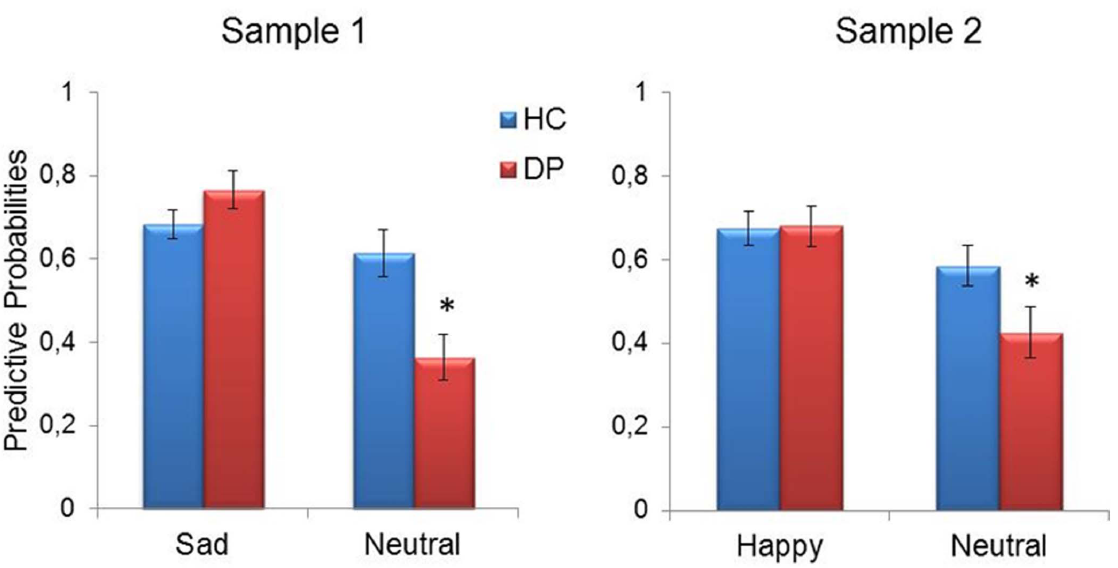
Figure 2. Results from Gaussian Process Classifier (GPC). Comparison of the predictive probabilities to patterns of brain activation to emotional and neutral faces between healthy controls and depressed patients. Note that the predictive probabilities to neutral faces in patients were significantly lower in comparison to the healthy controls. The data are presented with the mean and standard error to the mean. *p , 0.05.